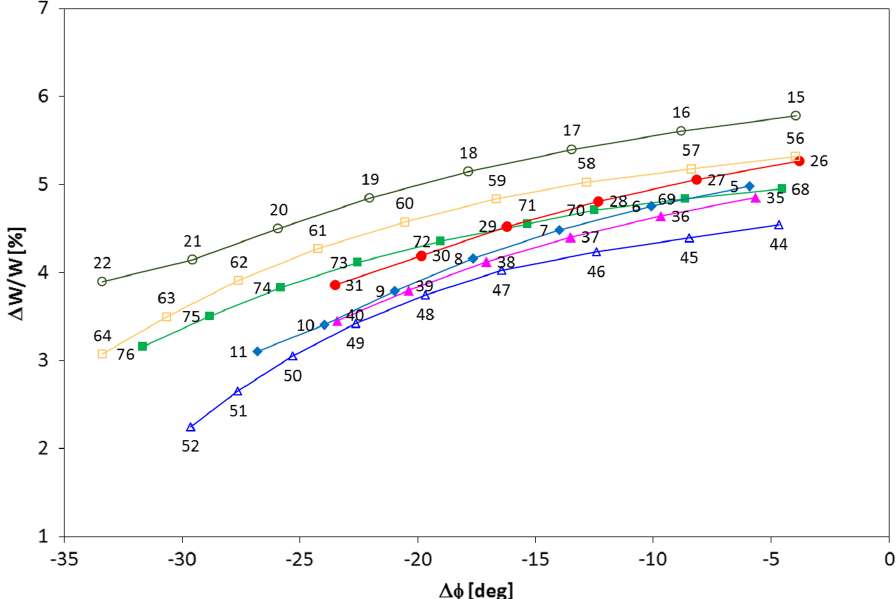
FIG. 11. Motions of beam bunch centers in the longitudinal phase space for all φ s ¼ 0 ° cells (with data labels indicating the cell